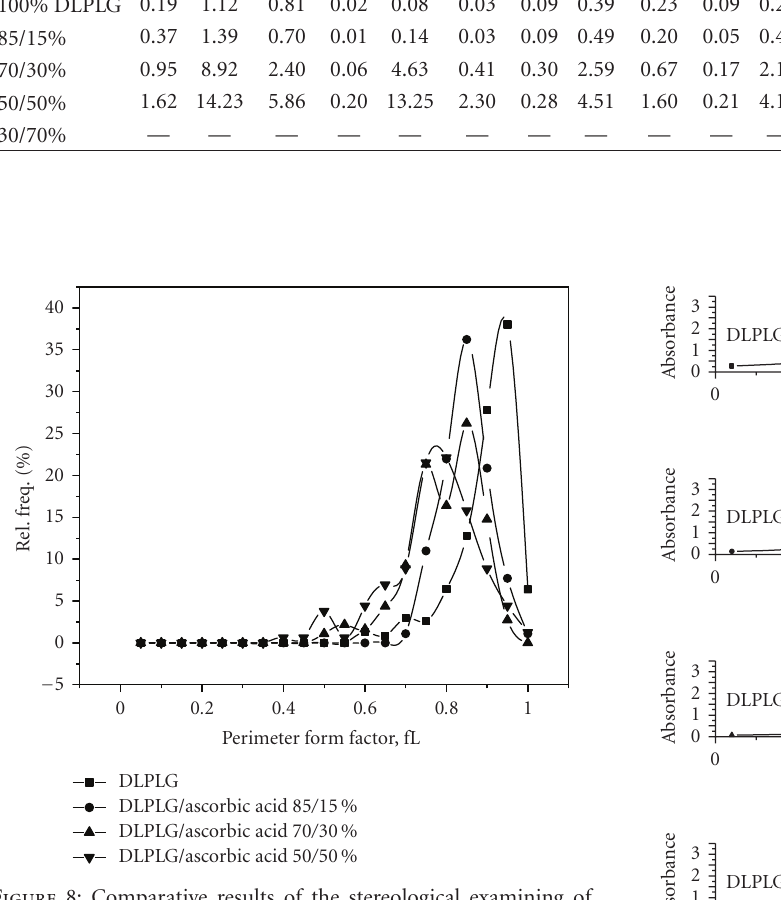
Figure 8: Comparative results of the stereological examining of DLPLG particles and particles with di ff erent ratio of DLPLG and ascorbic acid, DLPLG/ascorbic acid 85/15%, DLPLG/ascorbic acid 70/30%, DLPLG/ascorbic acid 50/50%, based on perimeter form factor fL.